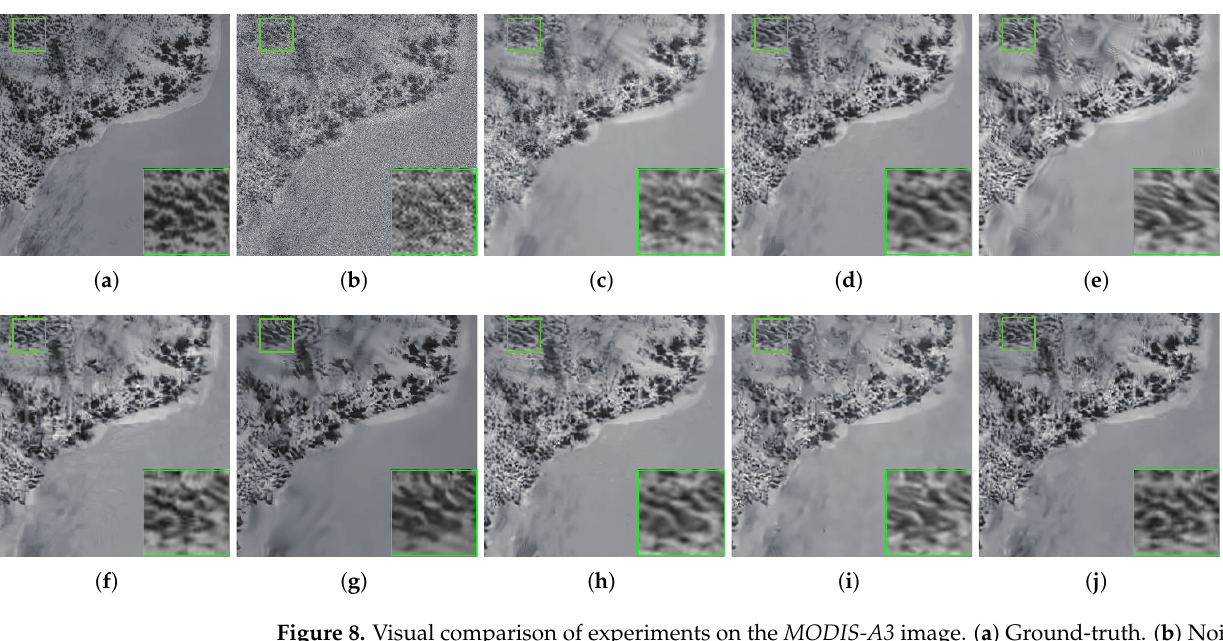
Figure 8. Visual comparison of experiments on the MODIS-A3 image. ( a ) Ground-truth. ( b )